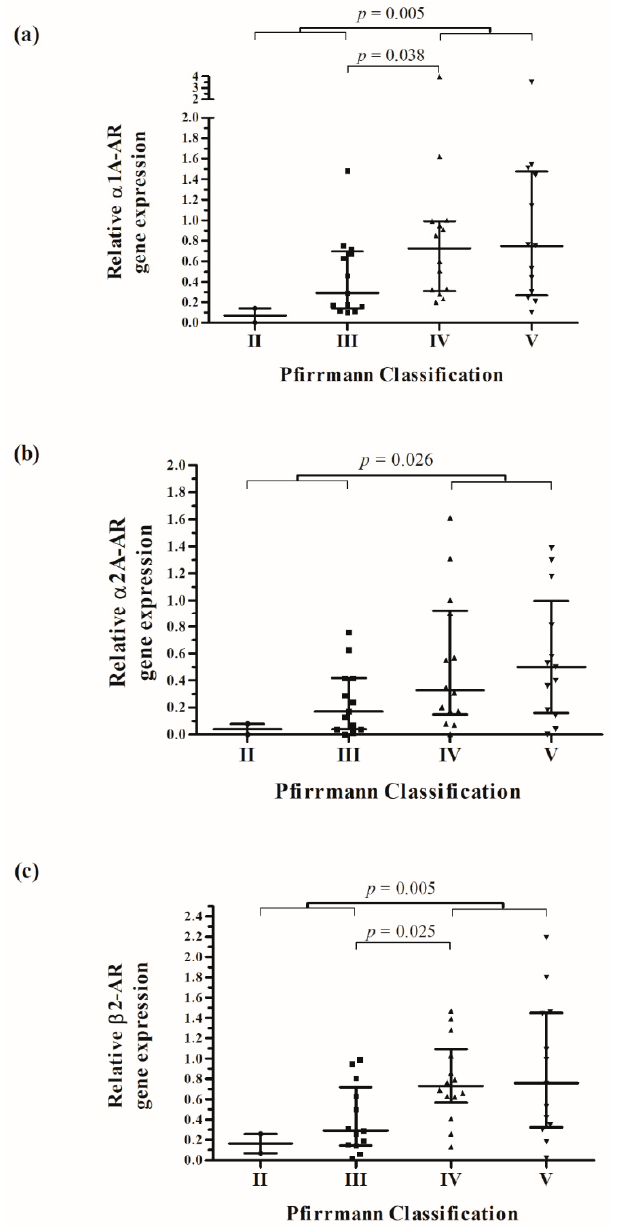
Figure 2. Correlation between relative α 1A- ( a ), α 2A- ( b ) and β 2-AR gene expression ( c ) in IVD tissue and radiological grade of IVDD (Pfirrmann classification). Each black reference point represents an individual patient (n = 42). Data represent medians with interquartile